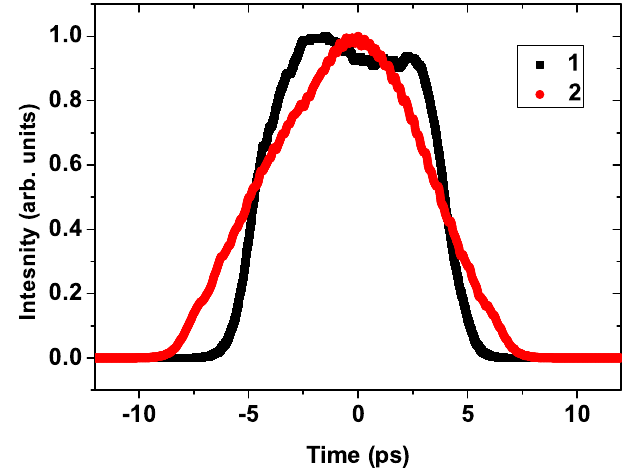
FIG. 14. (Color) Two different pulse shapes with the same FWHM (cid:2) 8 : 7 ps : (1) rise time (cid:3) 2 : 5 ps ; (2) rise time (cid:3) 5 ps .